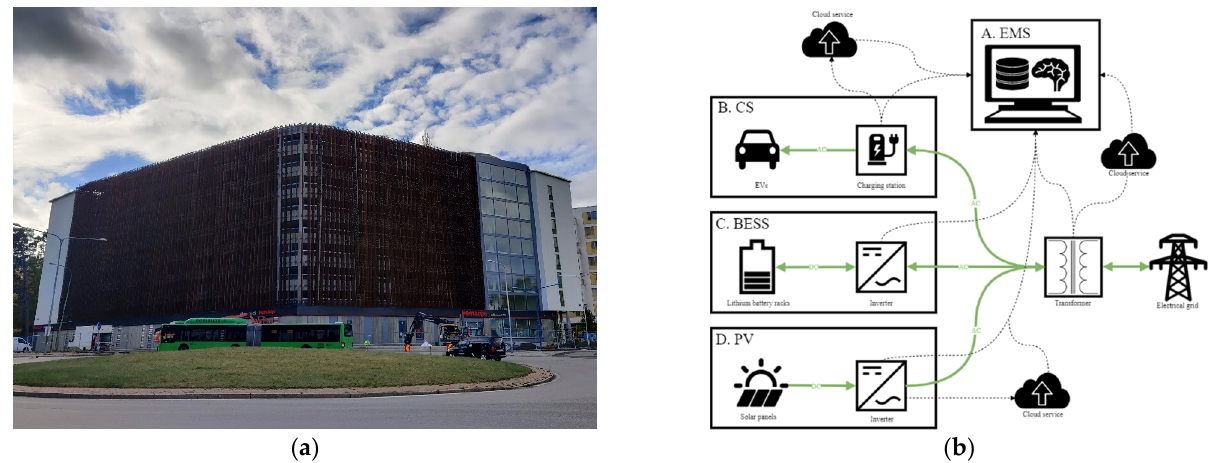
Figure 1. A photo of Dansmästaren ( a ) and a simplified schematic of its energy system ( b ). Table 1. Dansmästaren’s technical system specification. Parking